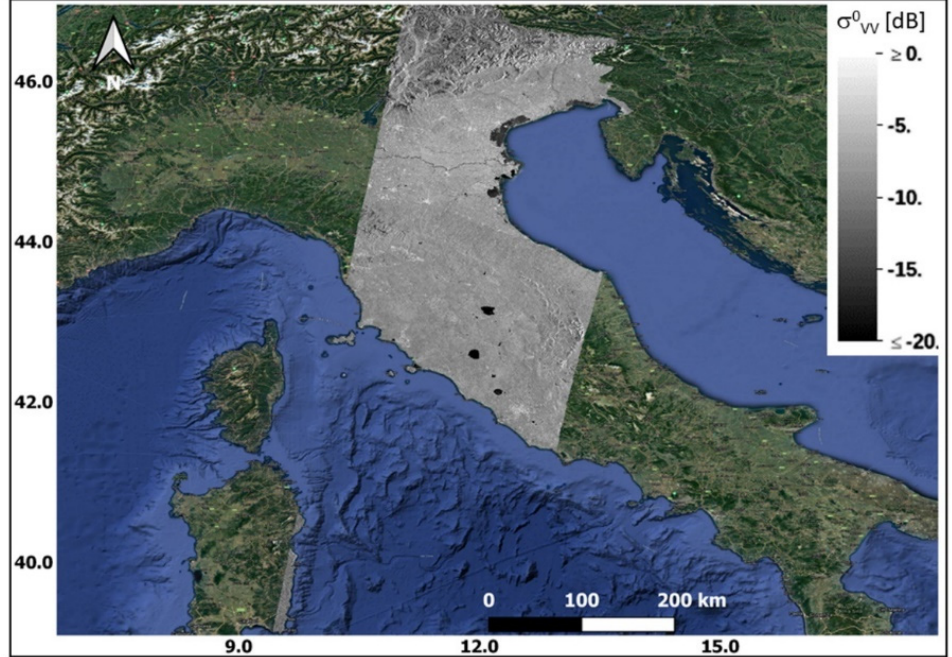
Figure 5. Example of output of the S1 data preprocessing block of AUTOWADE (relative orbit 95 and VV